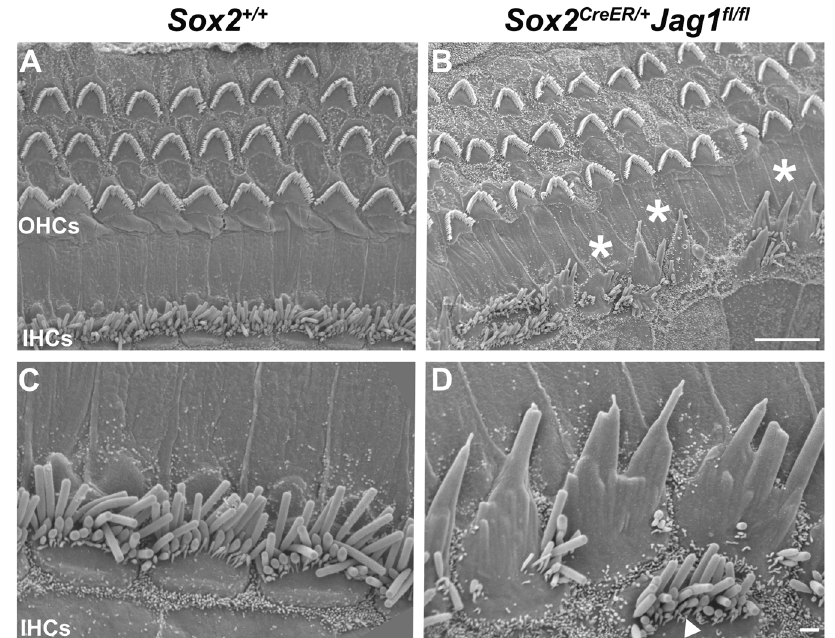
Fig. 7 Sox2 CreER/ + Jag1 fl / fl inner hair cells display stereocilia malformations. A – D Scanning electron microscopy (SEM) of the sensory regions of 6-week-old Sox2 CreER/ + Jag1 fl / fl and Sox2 + / + littermate cochleae. The majority of Sox2 CreER/ + Jag1 fl / fl inner hair cells ( B ; asterisks) display signi fi cant stereocilia fusion compared to Sox2 + / + littermate controls ( A ), although there are some hair cells with unfused stereocilia ( D ; arrowhead). However, outer hair cell stereocilia of the mutant mice appear to have normal morphology. Scale bar: 10 µm. C , D Higher power images of Sox2 CreER/ + Jag1 fl / fl inner hair cells further detail stereocilia fusion compared to Sox2 + / + littermate controls. Scale bar: 1